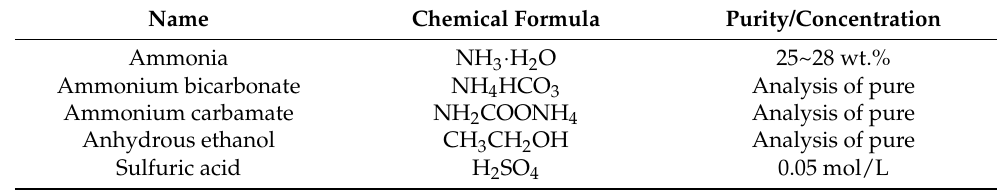
Table 1. List of experimental chemicals.